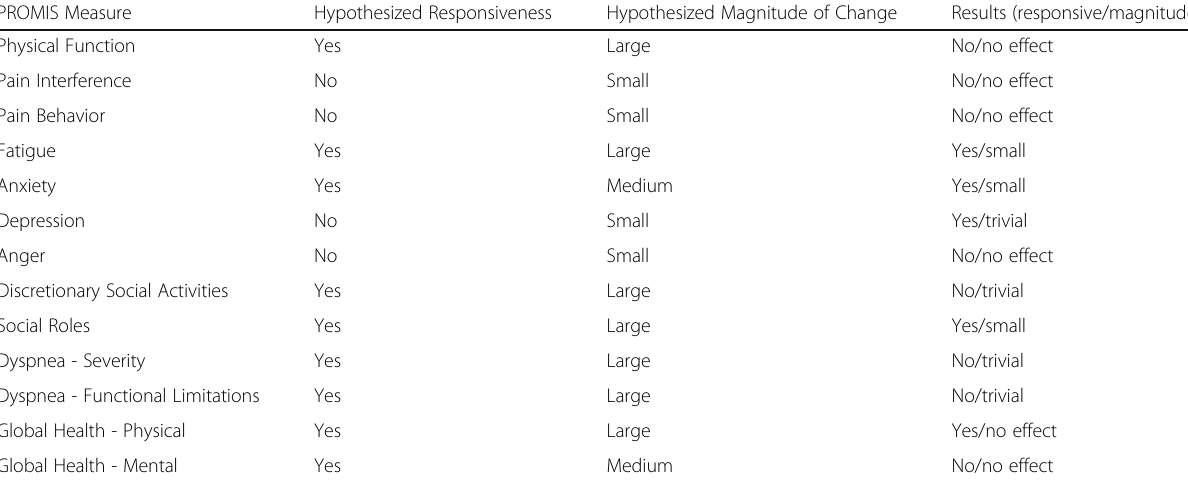
Table 1 PROMIS Measures and Hypothesized Responsiveness in COPD, with Results PROMIS